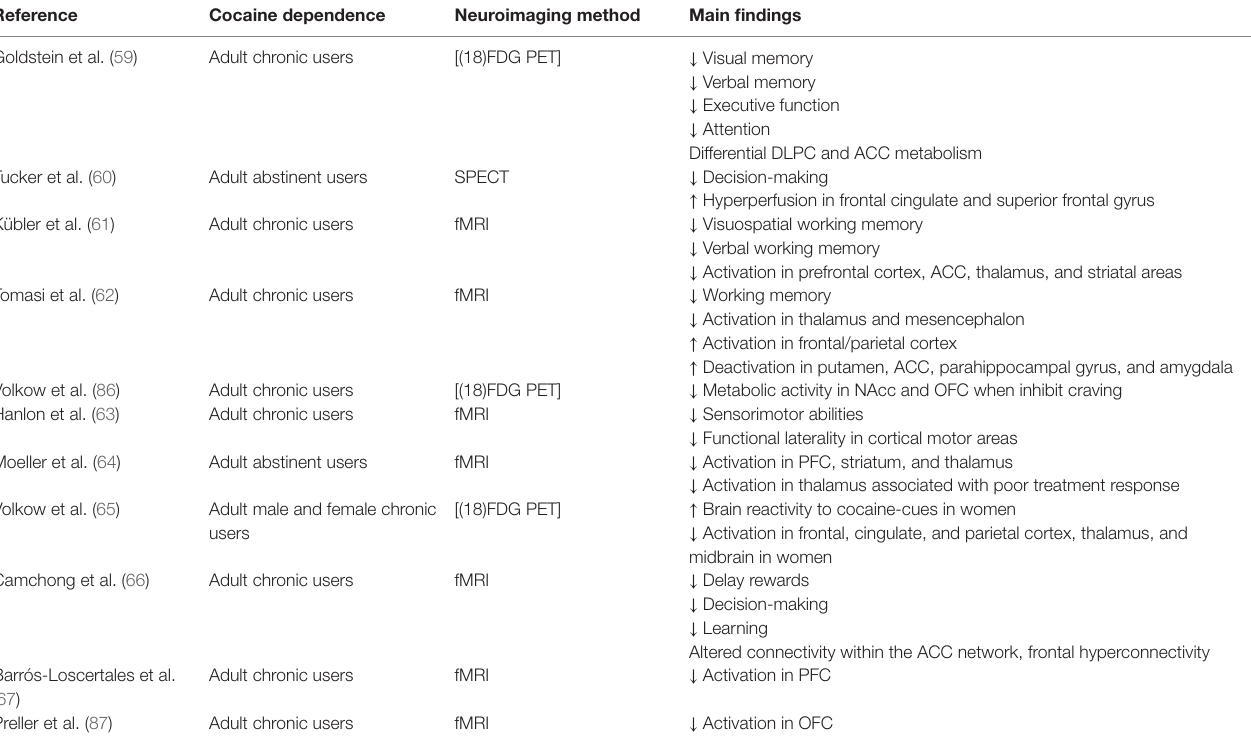
TABLe 4 | Functional neuroimaging studies on cocaine users performing cognitive